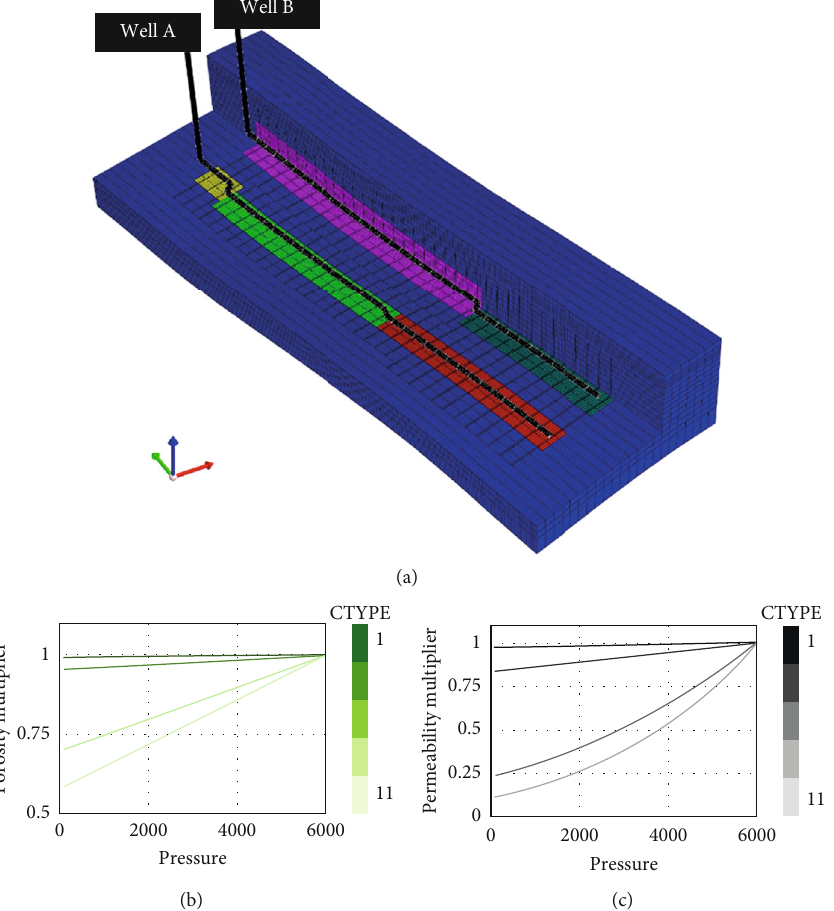
Figure 6: The porosity and permeability multiplier curve as function of pressure (left) and fi ve permeability enhanced zones based on variation in wellbore geometry